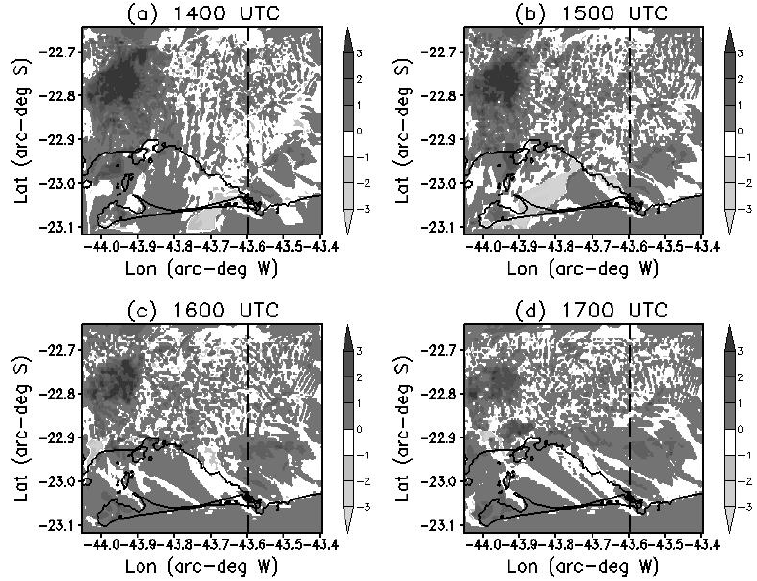
Figure 15. Horizontal cross section of the difference of potential temperature (K – shaded areas) between runs for the G5 domain, calculated as θ (HR) – θ (CTL), for (a) 14:00, (b) 15:00, (c) 16:00 and (d) 17:00UTC, 7 September